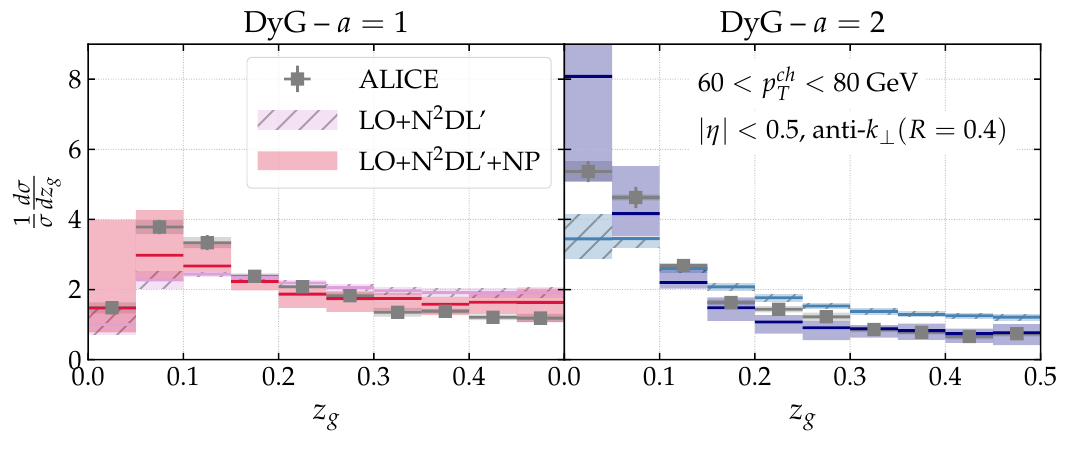
Figure 10 . Same as figure 9 for z g